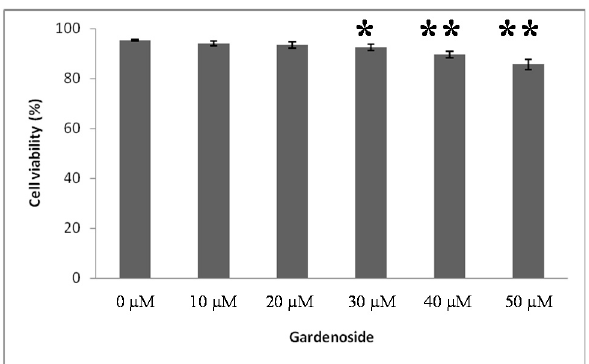
Figure 1. Cell viability assay. After treatment of Gardenoside and free fatty acids (FFAs) on the HepG2 cells, MTT assay was performed. Gardenoside was treated as 0, 10, 20, 30, 40 and 50 µM for 24 h. 10 and 20 µM of Gardenoside showed no toxicity to HepG2 cells. All experiments were repeated at least three times. * p < 0.05, ** p < 0.01, compared to 0 µM Gardenoside group.